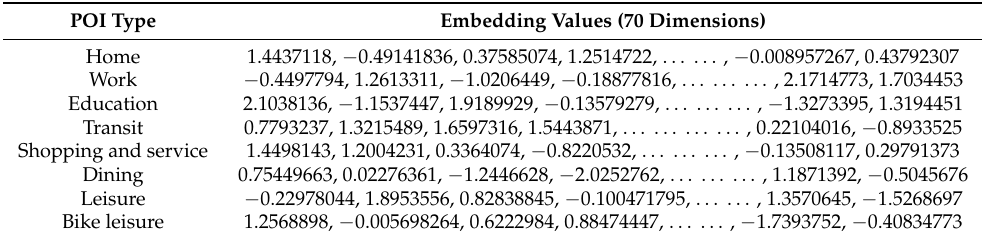
Table 6. Embedding values according to POI type.